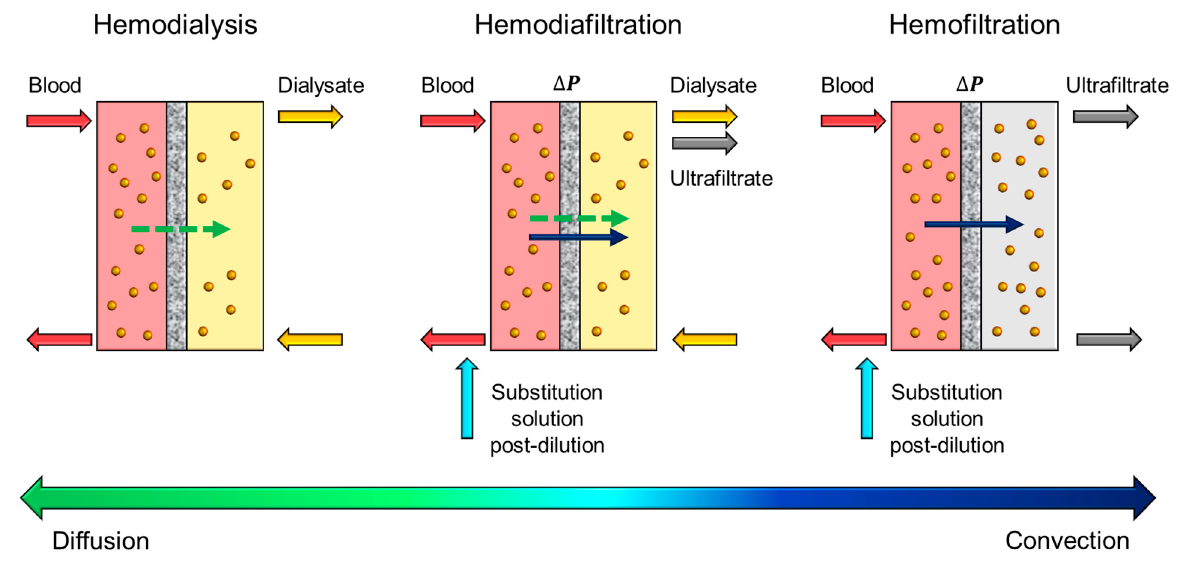
Figure 12. Schematic illustration of hemodialysis, hemodiafiltration and hemofiltration. Hemofiltration is similar to hemodialysis, but a transmembrane pressure is applied across the membrane to push the waste solutes and water through the membrane. Unlike hemodialysis, hemofiltration does not require a dialysate stream, but a substitution fluid is used to make up the lost blood volume. Additionally, as the applied pressure induces liquid convection through the membrane, hemofiltration can permeate large solutes faster than hemodialysis [143]. On the other hand, hemodiafiltration is a hybrid of the hemodialysis pressure gradient and increase the performance of the membrane